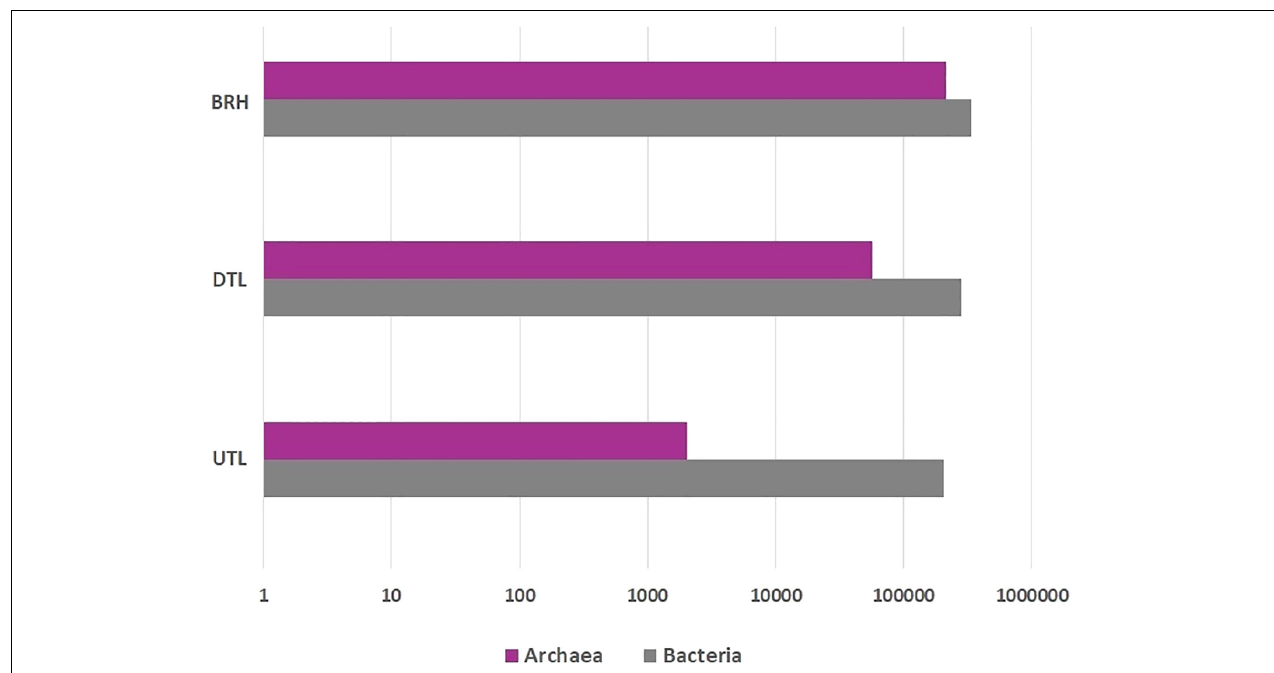
FIGURE 4 | Archaeal (purple), bacterial (grey) sequence distribution among bovine rawhides (BRHs), red damaged tanned leathers (DTLs), and undamaged tanned leathers (UTLs).